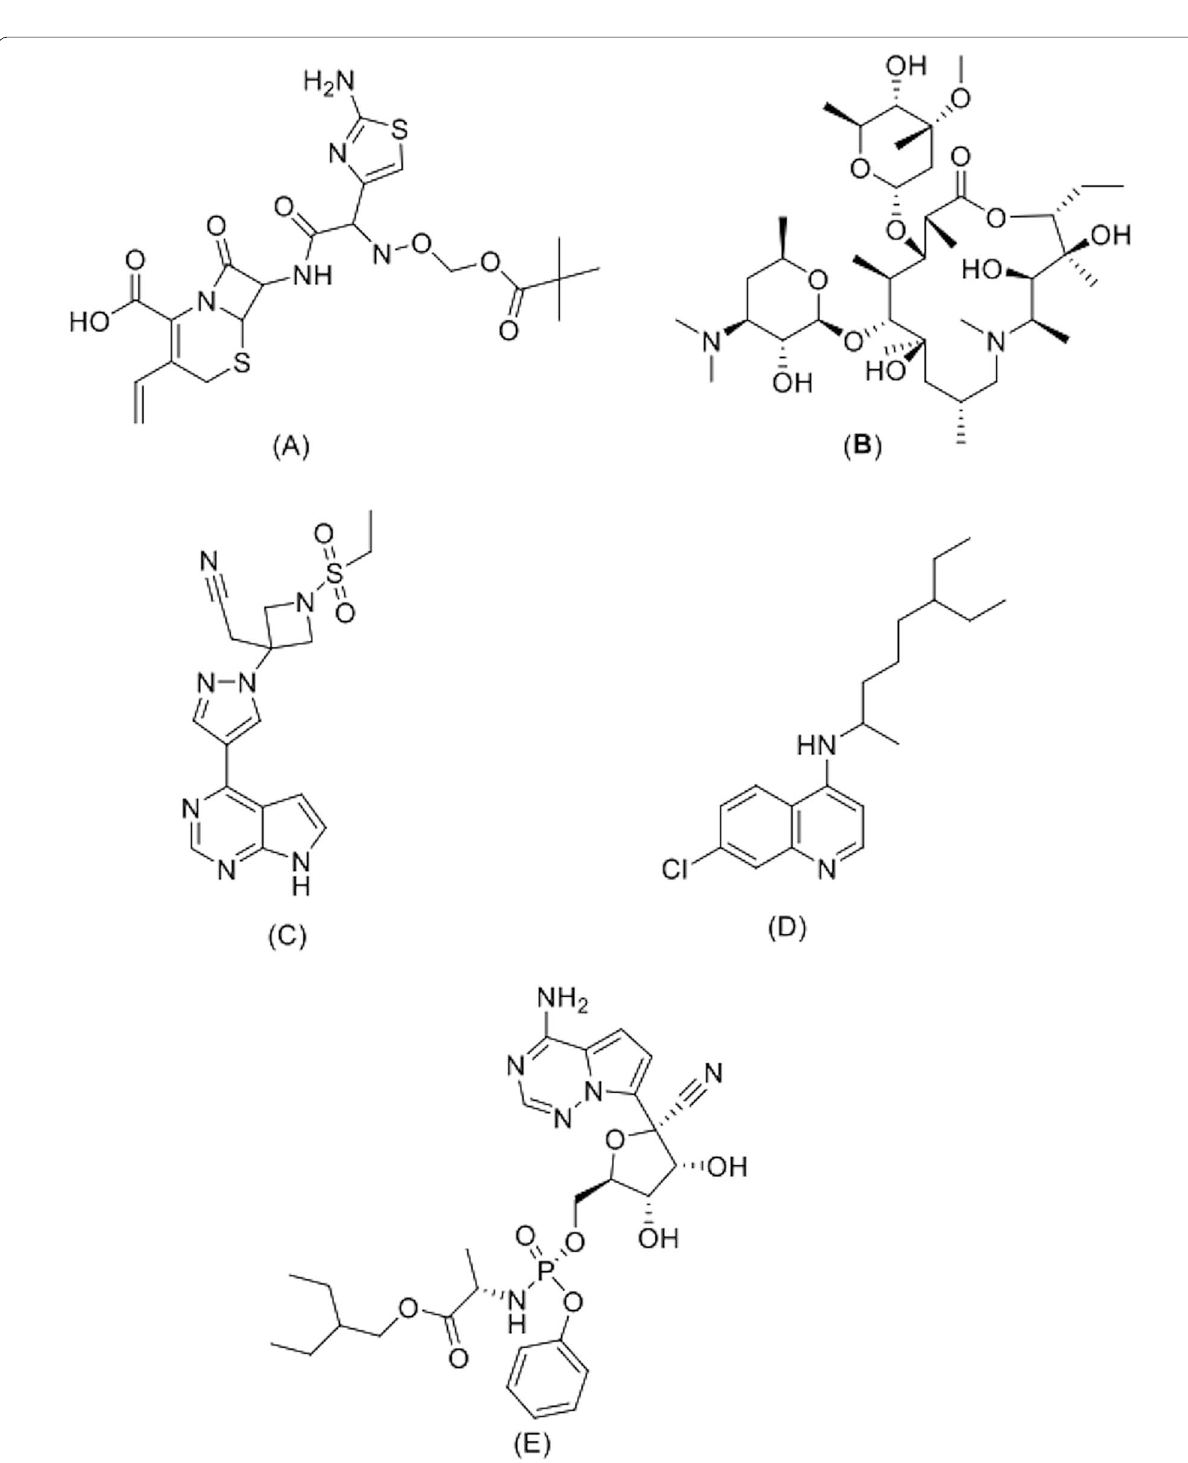
Fig. 2 Anti-SARS-COV-2 structural formula drugs used as control ligands. A Anakinra, B azithromycin, C baricitinib, D chloroquine e E remdesivir. Adapted from